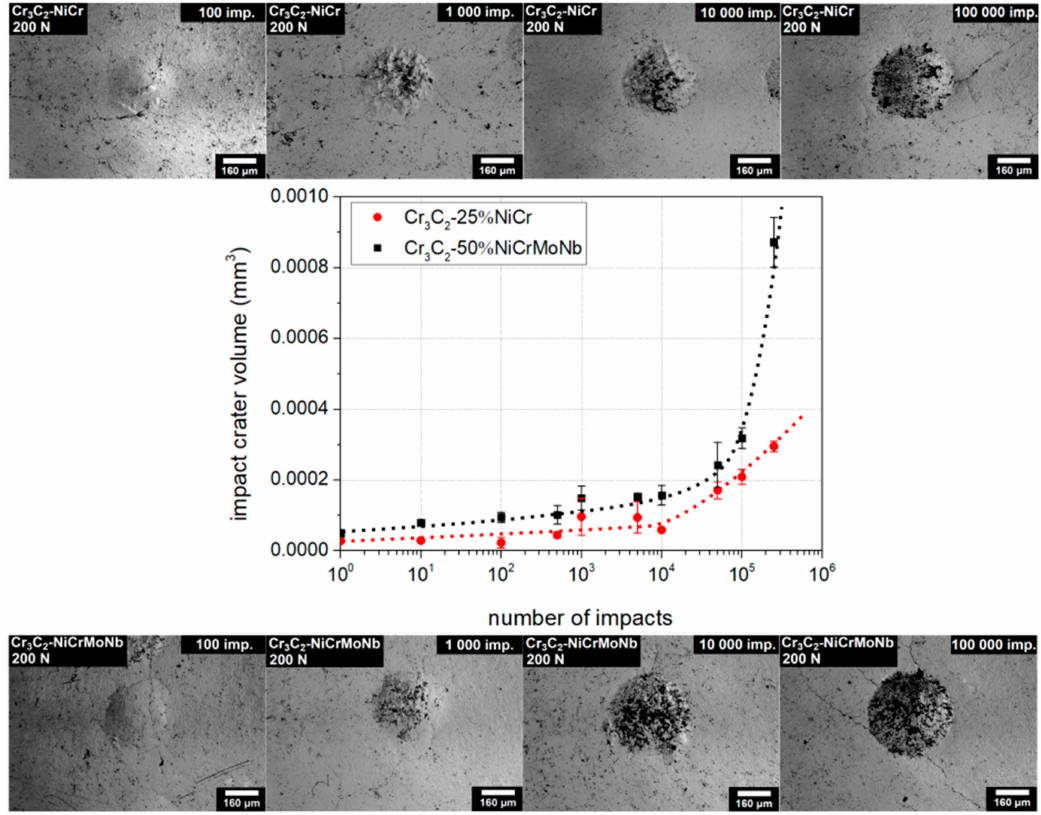
Figure 4. Comparison of the loading curves and impact craters of the studied coatings. The case for impact load of 200 N. Dotted lines were added as a visual